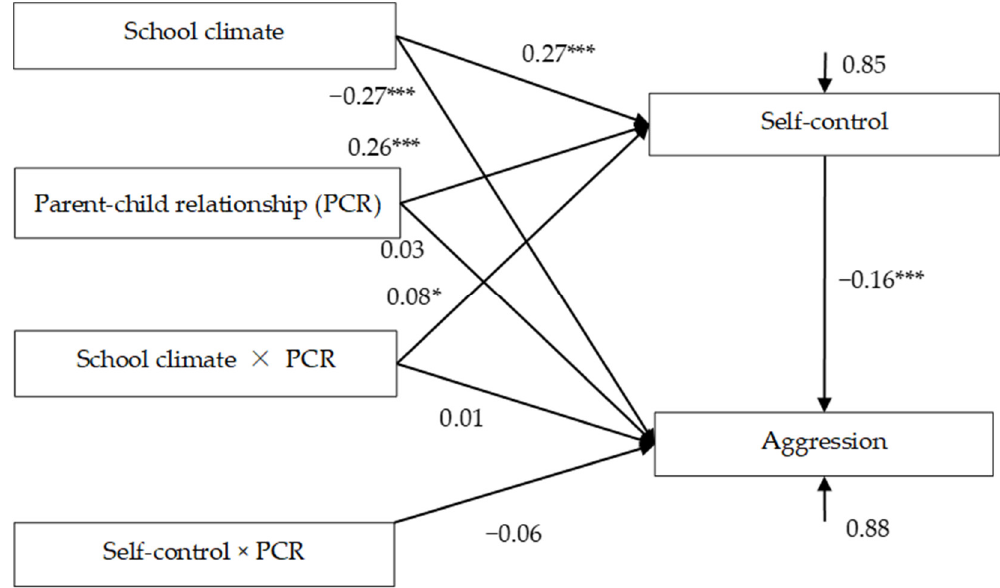
Figure 3. Model of the moderating role of parent-child relationship on the indirect relationship between school climate and aggression via self-control. Values are standardized coefficients. * p < 0.05 ， *** p < 0.001.